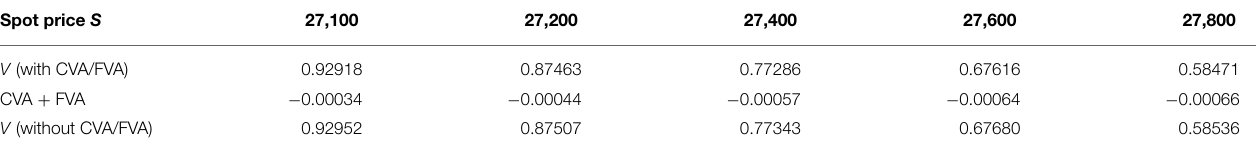
TABLE 16 | Prices of first-touch digital under KoBoL as of 28 May 2015, time to maturity T = 0 . 0877 , barrier H = 27 , 000 , risk-free rate r = 0 . 25 % , collateral rate